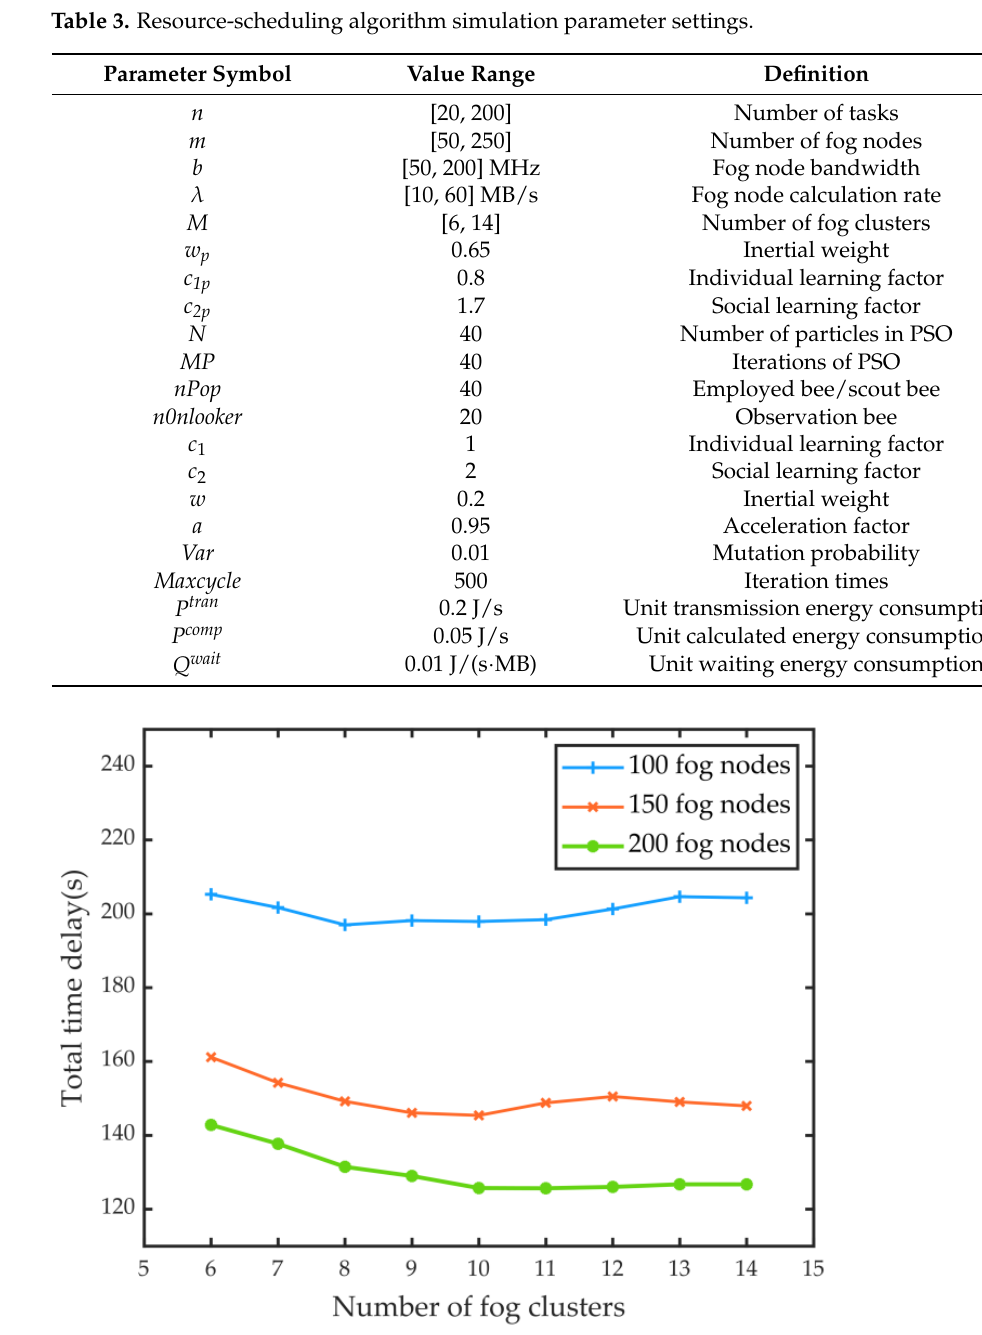
Figure 7. Total delay varies with fog cluster number in three environments. It can be seen from Figures 7 and 8 that, for 100, 150, and 200 fog nodes, fewer fog clusters resulted in a lower energy consumption, but larger latency. The energy consump- tion increased significantly with the quantity of fog clusters, and the delay decreased with the quantity of fog clusters until the delay curve plateaued after the number of fog clusters reached 10. Thus, the optimal value of the quantity of fog clusters was 10 when the quantity of fog nodes was around 100, 150, and 200. At this point, the system was most stable in terms of the processing